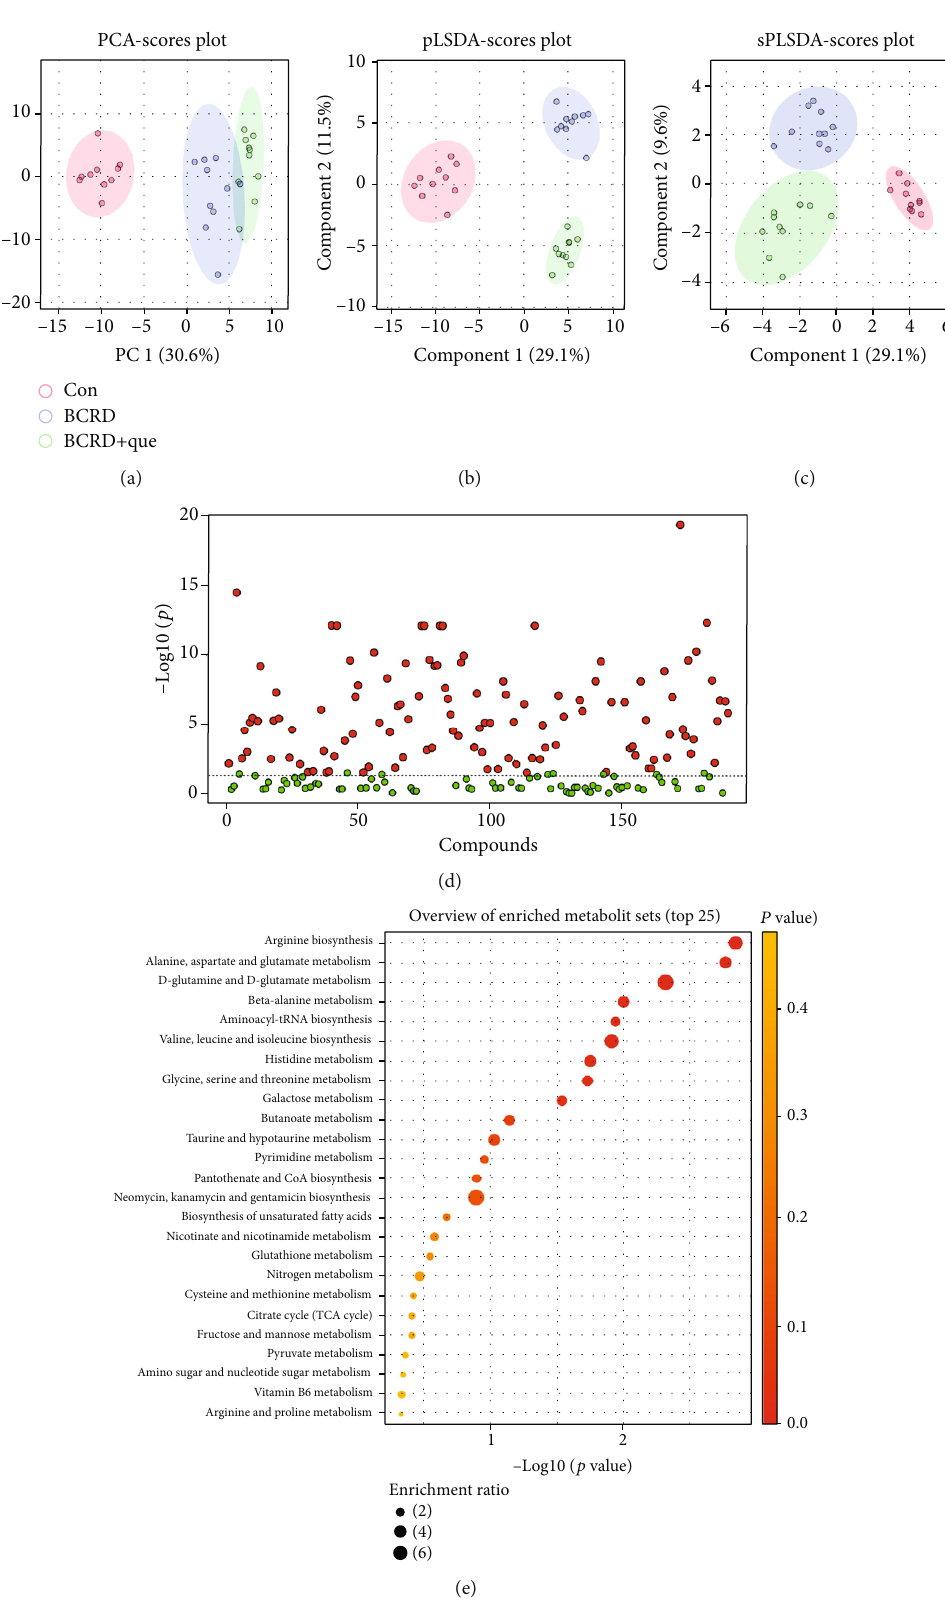
Figure 7: Quercetin might promote the antitumor immune response in BCRD mice via regulation of serum metabolism. (a) Principal component analysis. (b) Partial least squares discriminant analysis (PLS-DA). (c) Sparse partial least squares discriminant analysis (SPLS- DA). (d) Di ff erential metabolites are represented by a volcano plot. (e) KEGG pathway enrichment analysis of di ff erential